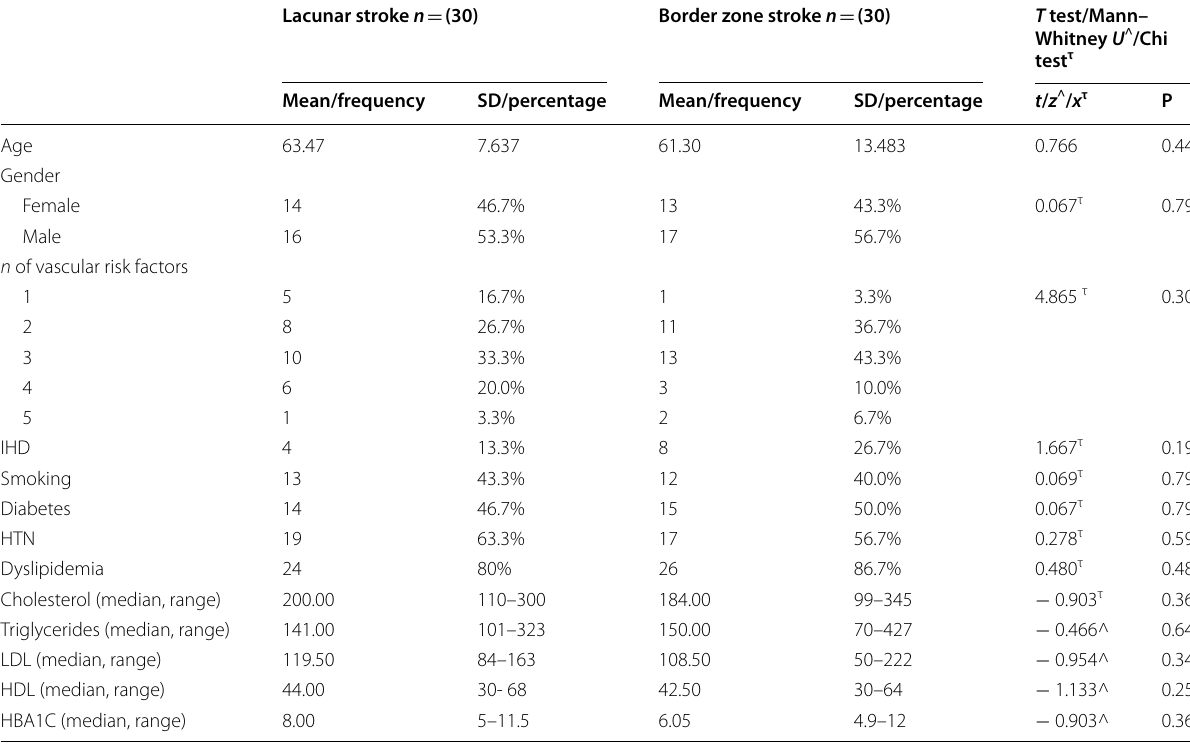
Table 1 Demographic data, risk factors and laboratory findings